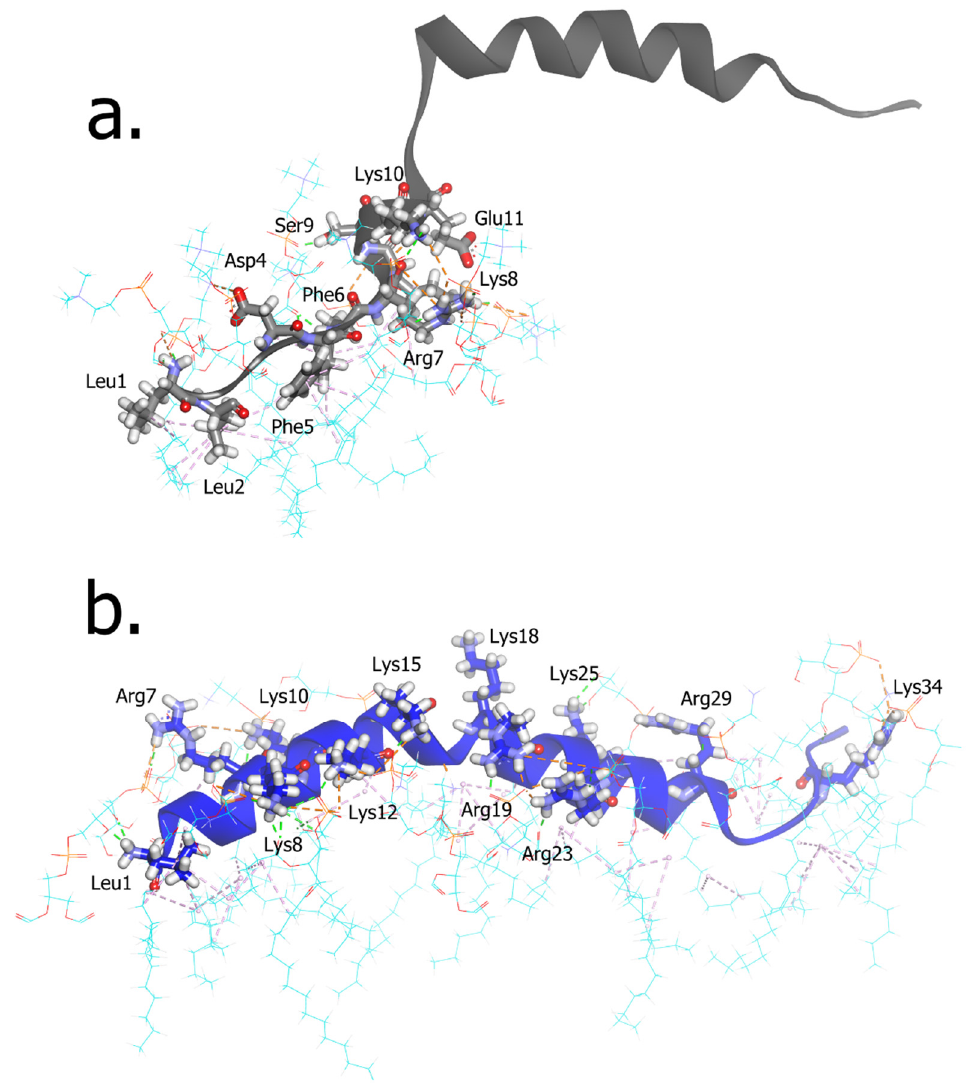
Figure 3. The residual interactions of the N-terminal of LL-37 with POPC ( a ) and the basic amino acids of LL-37 with POPE:POPG membrane ( b ). The structure of LL-37 is shown as black and blue cartoon model; N atoms: blue, O atoms: red, P atoms: orange, tails of phospholipids: cyan.